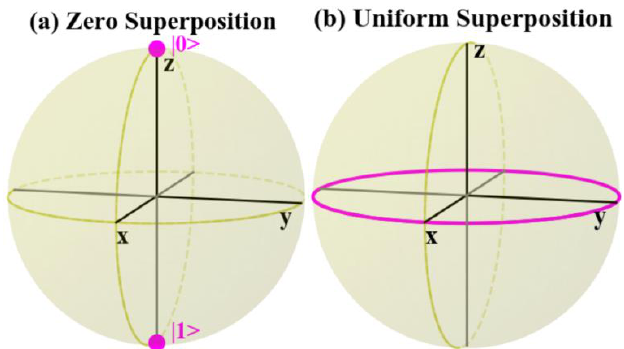
Figure 1. Single-qubit Bloch sphere: ( a ) the zero superposition states, |0 ⟩ and |1 ⟩ , and ( b ) the uniform superposition states. The sine value of the polar angle of the Bloch vector is zero for ( a ), and unity for ( b ).